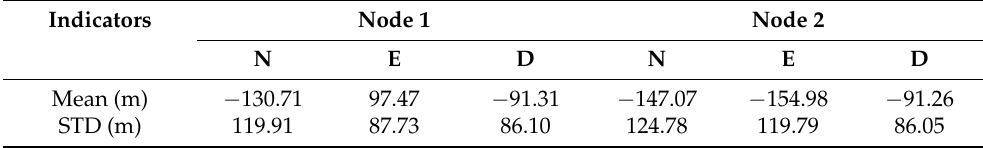
Table 3. Statistics of pure INS navigation positioning position error.